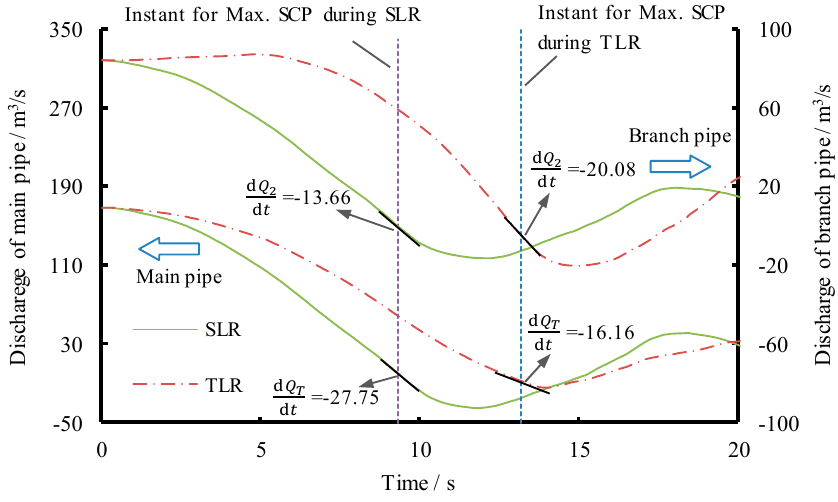
Figure 8. Spiral case pressure of different η 1 versus time for Scenario 1.